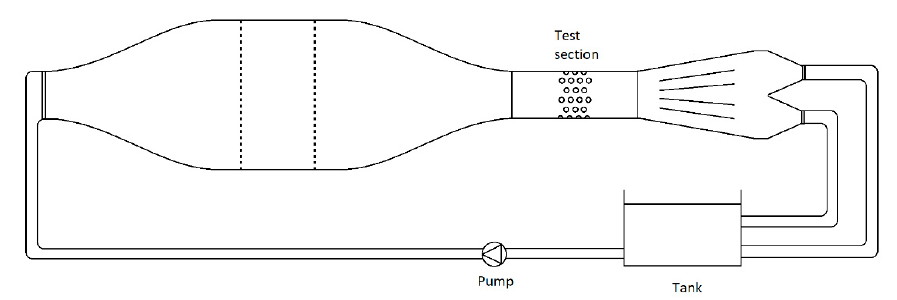
Figure 2. Hydraulic channel experimental overall